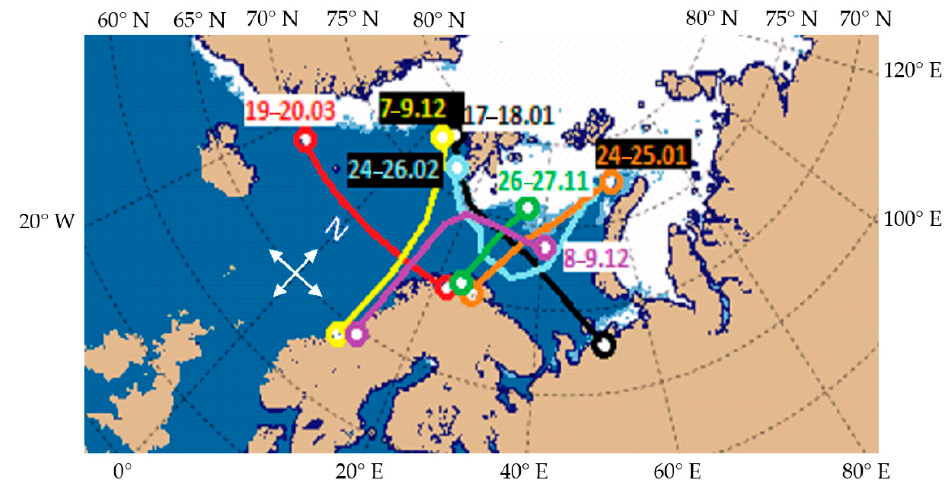
Figure 1. Trajectories of polar lows. Cold period: November 2019–March 2020. The date shows the start point of the trajectory. Base map of this picture is a map of Ice Edge from EUMETSAT (European Organization for the Exploitation of Meteorological Satellites). ©EUMETSAT 2020.